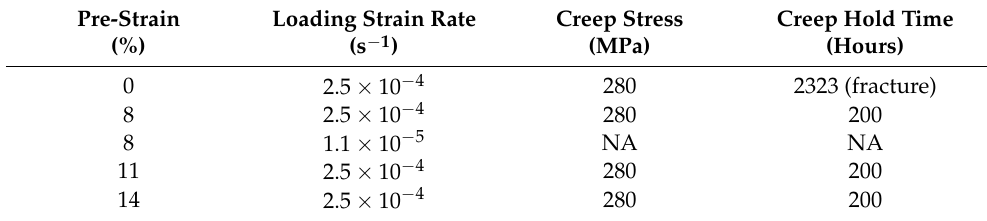
Table 2. Testing regime for determining effect of high-temperature plastic pre-strain on subsequent creep rate.